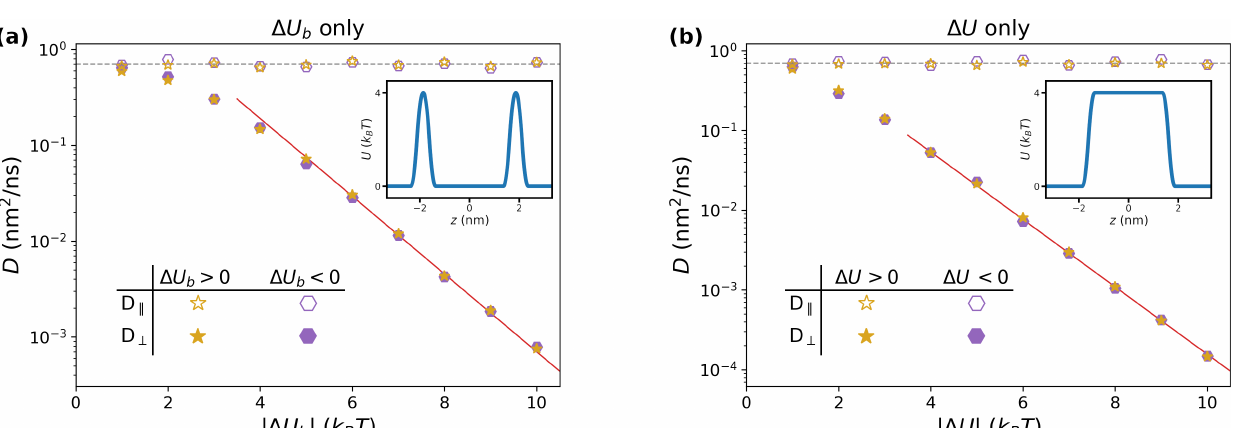
Figure 2. Representative evolution of mean-square displacement as a function of time for = D wat . In both panels, filled and empty | ∆ U | = 4 ( a ) and | ∆ U | = 8 ( b ), while ∆ U = 0 and D b b lip symbols correspond to MSD ⊥ and MSD (cid:107) , respectively, as reported in the legends. The dashed lines correspond to the formula 4 D wat t . In the insets, the potential of mean force for each case is reported.